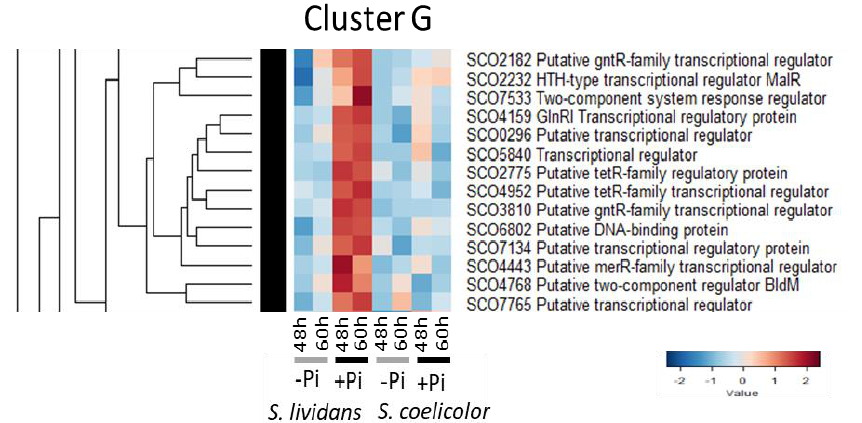
Figure 8. Cluster G, heatmap representation of transcriptional regulators and sensory histidine kinases more abundant in Pi proficiency than in Pi limitation in SL but not in SC .